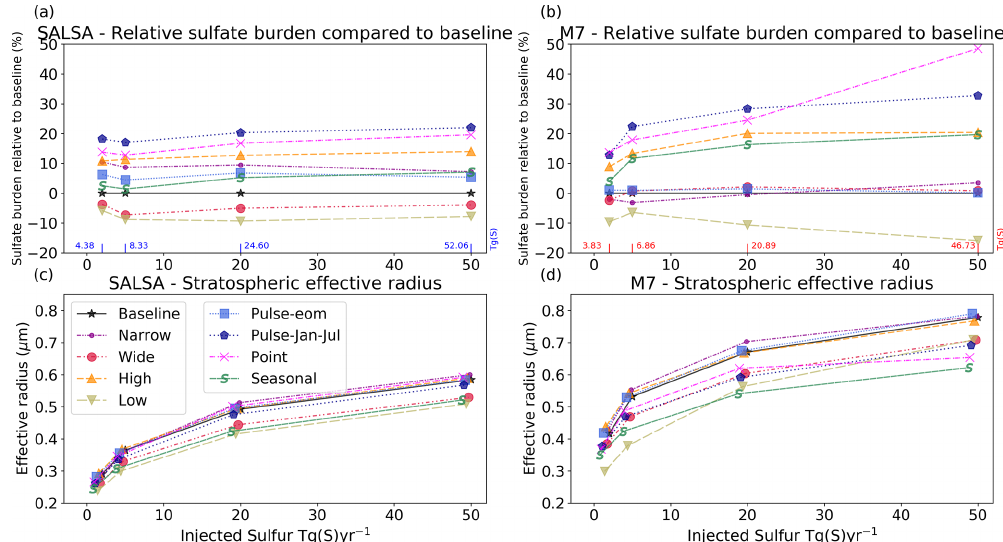
Figure 7. (a,b) The relative stratospheric sulfur burden in sensitivity scenarios compared with the Baseline scenario with its corresponding sulfur injection rate. (c,d) The global mean effective radius of stratospheric aerosols